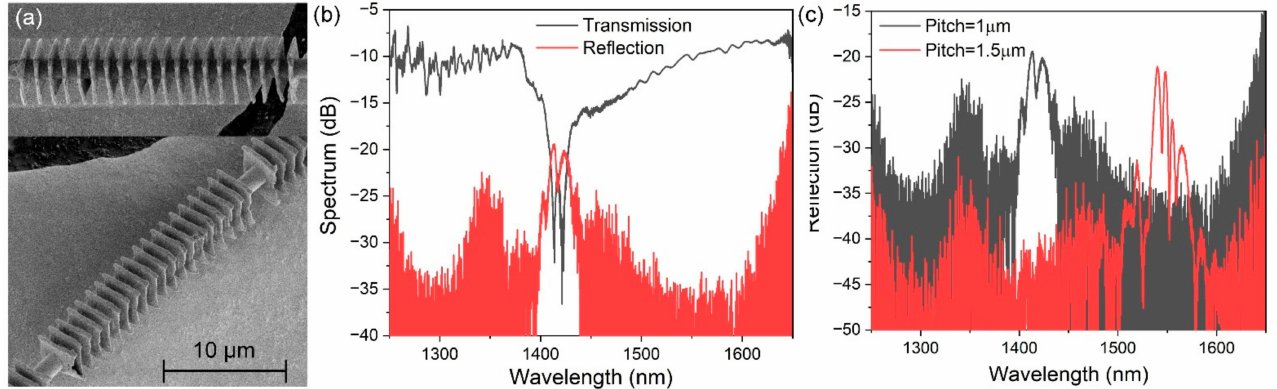
Figure 2. Characteristics of the proposed fully encircled µ -PFBG device. ( a ) The SEM images of the encircled µ -PFBG on a microfiber with a diameter of 2 µ m. ( b ) The transmission and reflection spectrum in alcohol solution. ( c ) The comparison of the resonance reflection spectrums of the fully encircled µ -PFBG with the grating units pitch of 1 µ m and 1.5 µ m, with other dimensions being